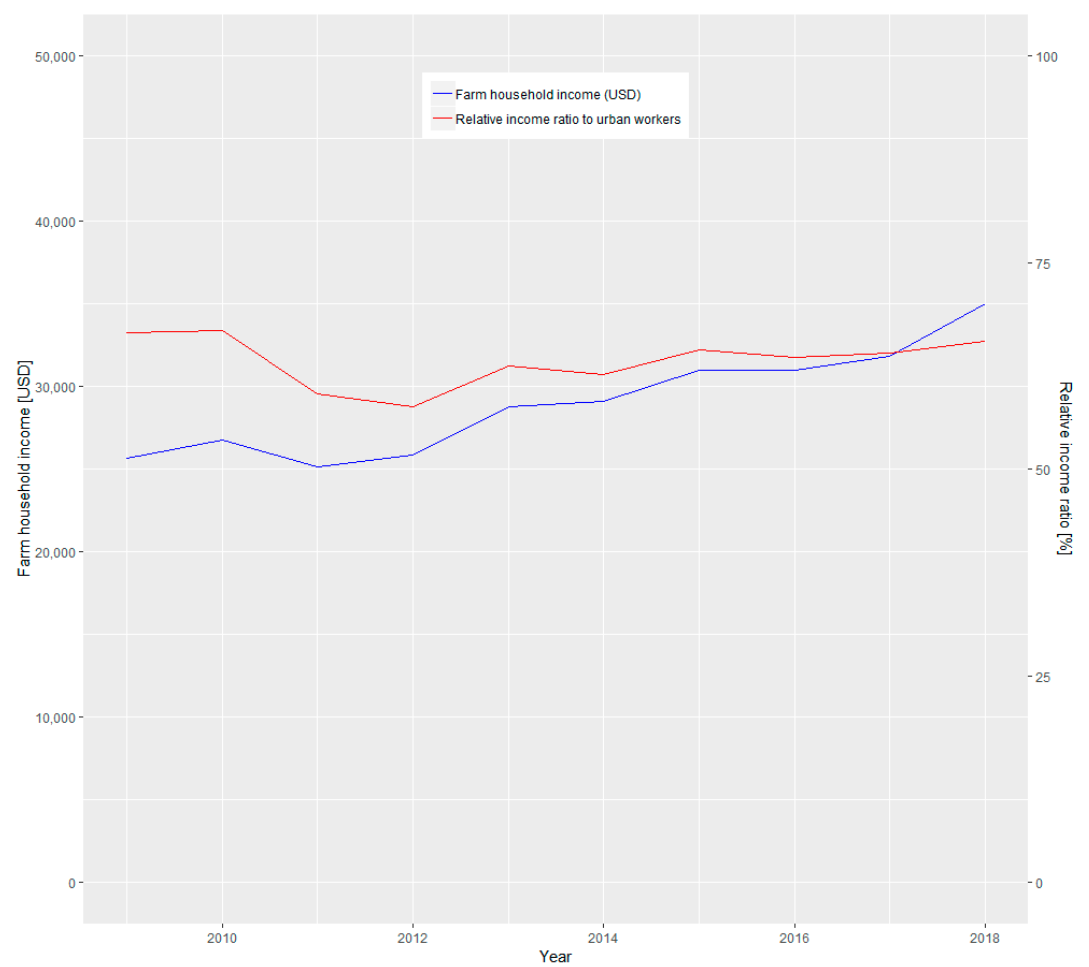
Figure A1. Trend of Korean farm household income and relative income ratio [5].